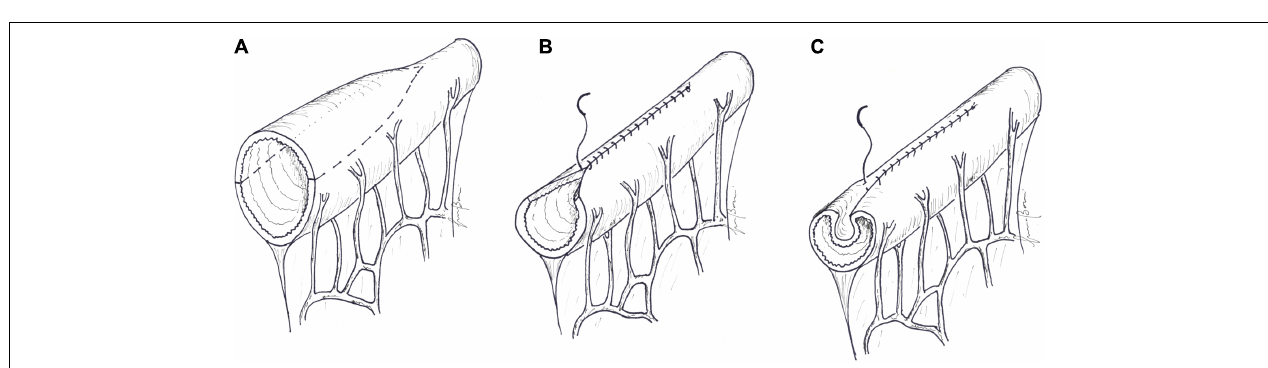
FIGURE 3 | (A) In tapering, a wedge-shaped strip of the antimesenteric border is resected and (B) the remaining bowel is sutured into a tube. (C) In plication, the antimesenteric border of the dilated bowel is folded into the lumen, and the lateral margins are sutured.